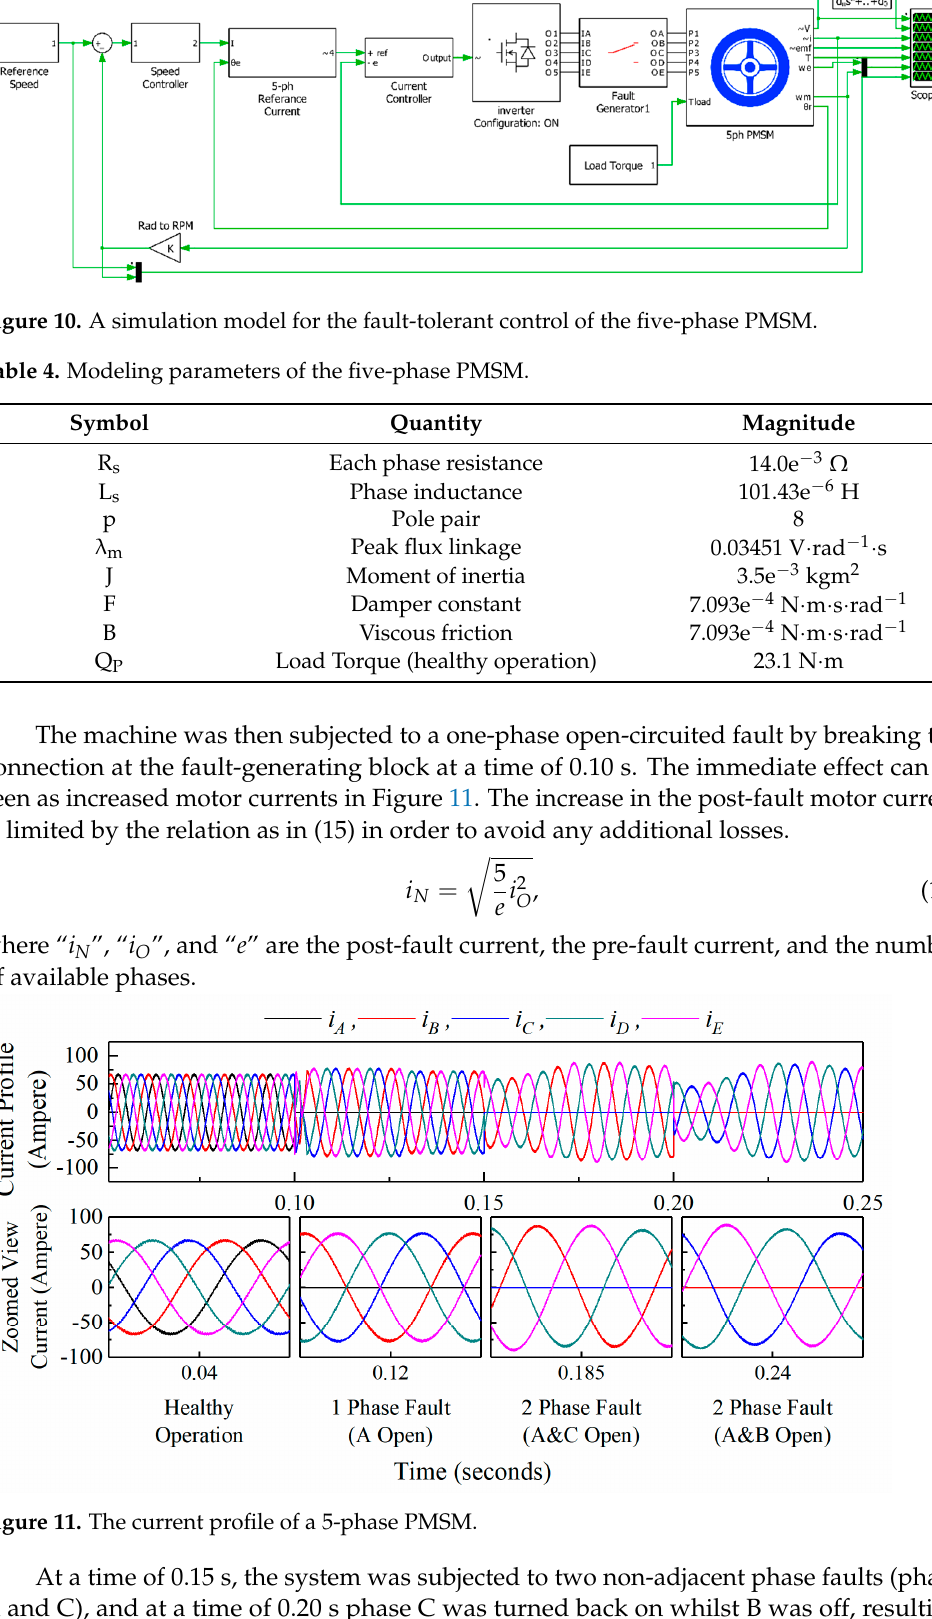
Figure 12. Current and back-emf profiles in the case of healthy operation and one- and two-phase fault operations. The torque and speed outputs of the machine are illustrated in Figure 13. The output torque is reduced by 19% in the case of a one-phase fault, 46% in the case of two adjacent phase faults, and 32% for non-adjacent phase faults. This drastic amount of reduction in torque is due to current limitation it can be slightly increased by raising the current limit. The relation between torque and speed is presented earlier in (5), and the output speed is illustrated in Figure 13, showing a little turbulence in two phase fault operation. Figure 14 illustrates the phase voltages of the five phase PMSM during healthy and faulty oper- ation. It can be seen that no reasonable increase in voltage amplitudes. The numerical val- ues of the simulated results can be seen in Table 5.